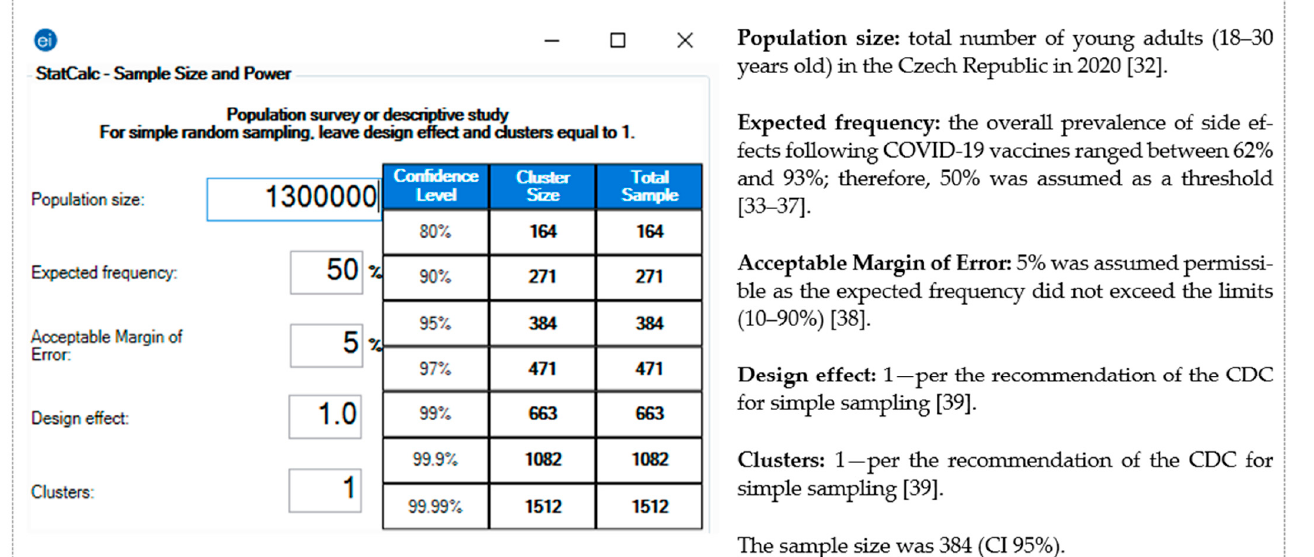
Figure 1. Sample size of the young adults (18–30 years old) in the Czech Republic — Epi-Info TM version 7.2.4 .